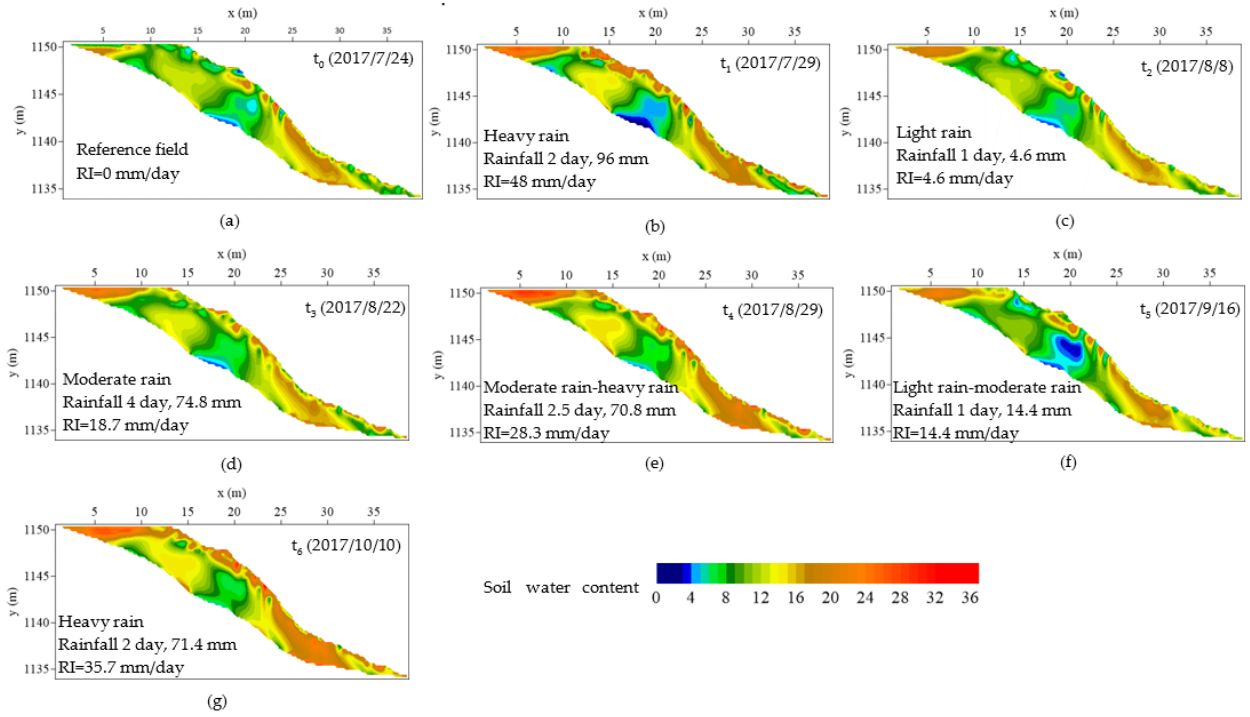
Figure 8. Soil water content field based on the conversion of apparent resistivity (x = Distance, y = Elevation). ( a – g ) is the distribution of slope soil water content field under different rainfall conditions.